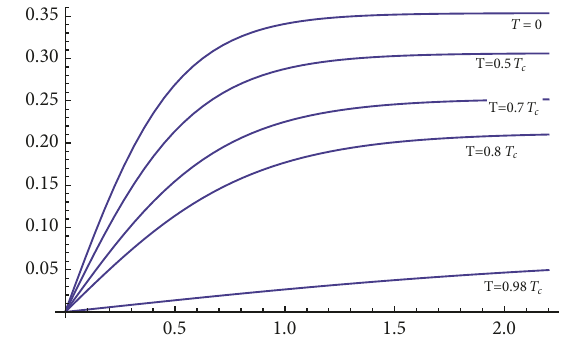
Figure 3: A plot of the color dielectric function 𝐺(𝑟, 𝑇) against 𝑟 for 𝑇 = 0.5𝑇 , 𝑇 = 0.7𝑇 𝑇 = 0.8𝑇 , 𝑇 = 0.98𝑇 𝑇 = 0 1 𝑐 2 𝑐 , 3 𝑐 4 𝑐 , and